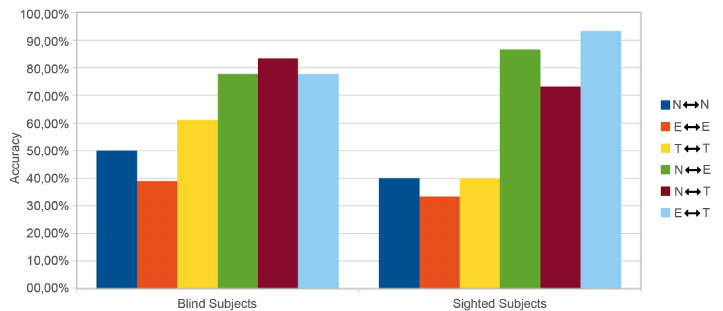
Figure 17. Accuracy by category - variable